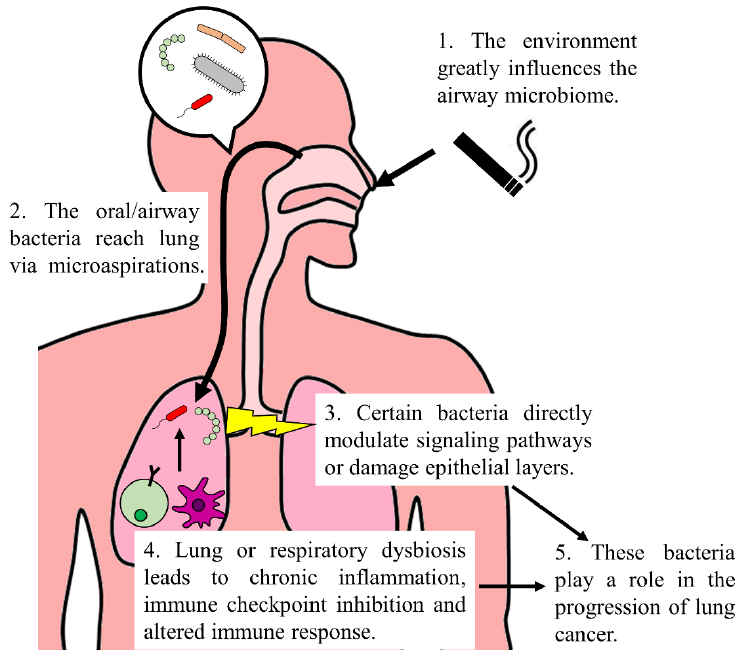
Figure 1. Involvement of the microbiome in lung cancer. The environmental factors (e.g., smoking) are the primary cause of variations in oral and airway microbiomes. These bacteria reach lung via microaspirations. Certain bacteria, like Veillonella and Acidovorax , can directly upregulate ERK and PI3K signaling pathways or damage epithelial cells. Moreover, lung or respiratory dysbiosis reshapes immune response, leading to aggravated Th17 and neutrophil responses, chronic inflammation and elevated levels of immune checkpoint molecules. Taken together, these microorganisms contribute to lung cancer development.